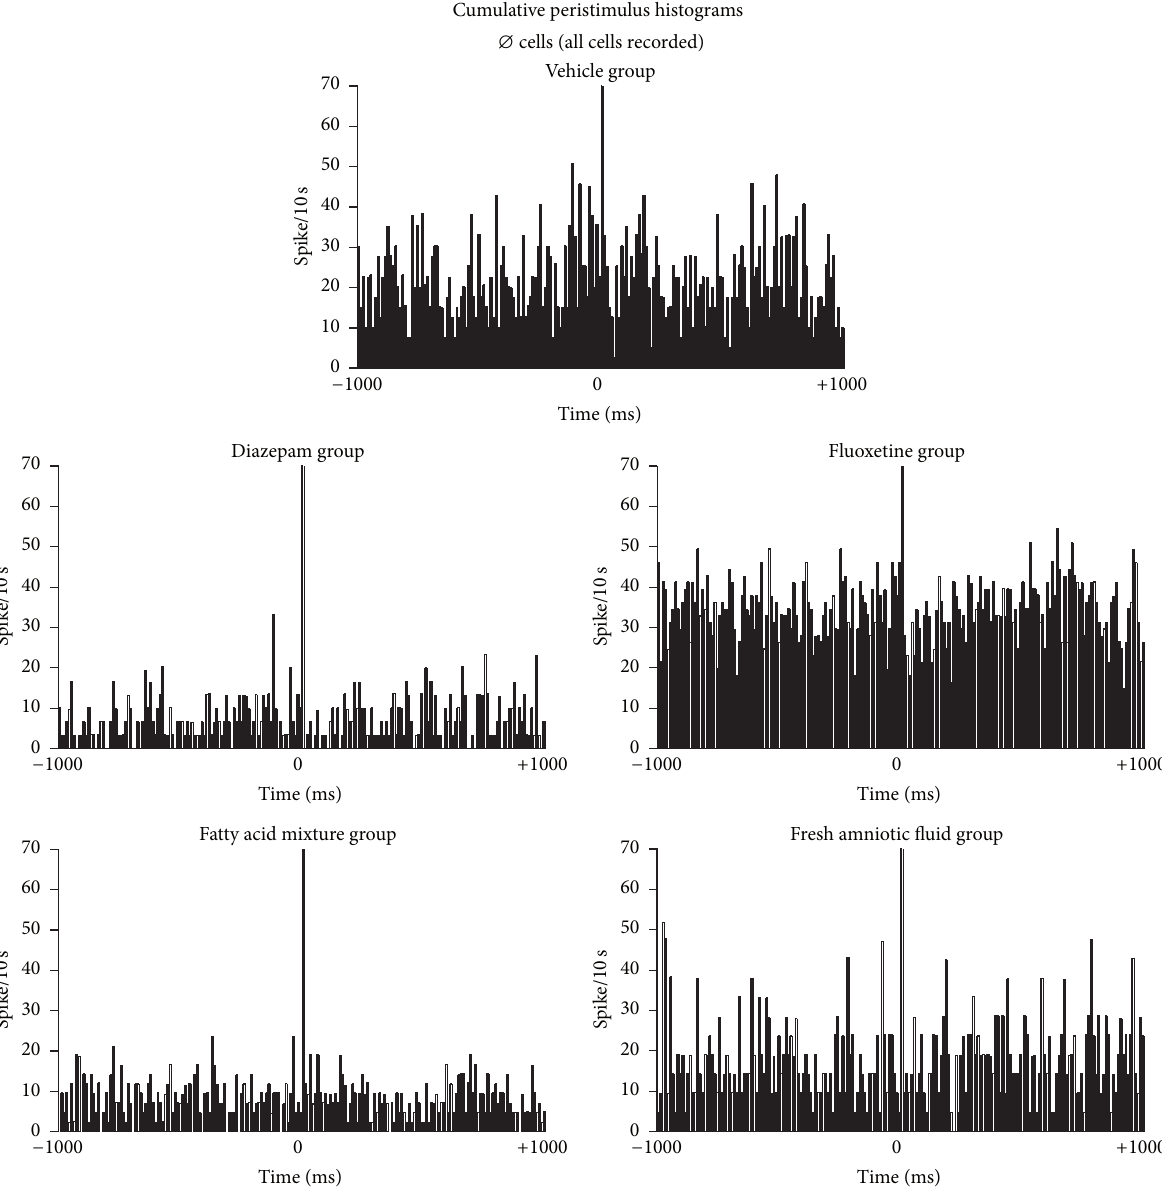
Figure 5: Cumulative peristimulus histogram for septal neurons that did not respond to amygdala stimulation (Ø cells). As expected, the differences were minimal and nonsignificant. The coordinates are the same as in Figure